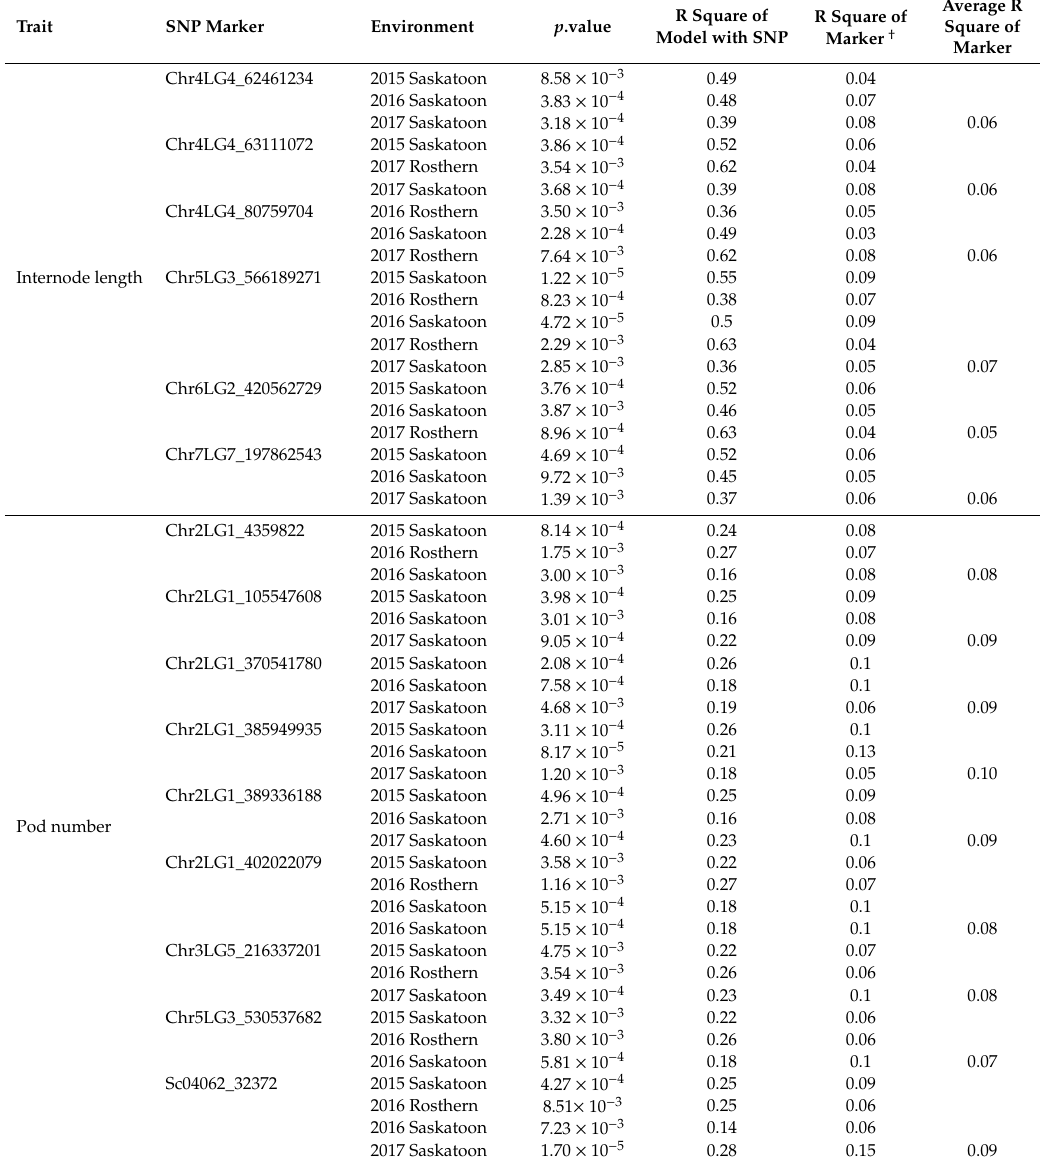
e ff ects with a relatively lower broad sense heritability of 0.57 (Table 2; Table 3; Figure 1). Two SNP markers (Chr4LG4_415994869 and Chr5LG3_309595819) were associated with CT in three of the five environments. The R-square value of the model with SNP ranged from 0.43 to 0.53, and each of the SNP markers explained 6% of